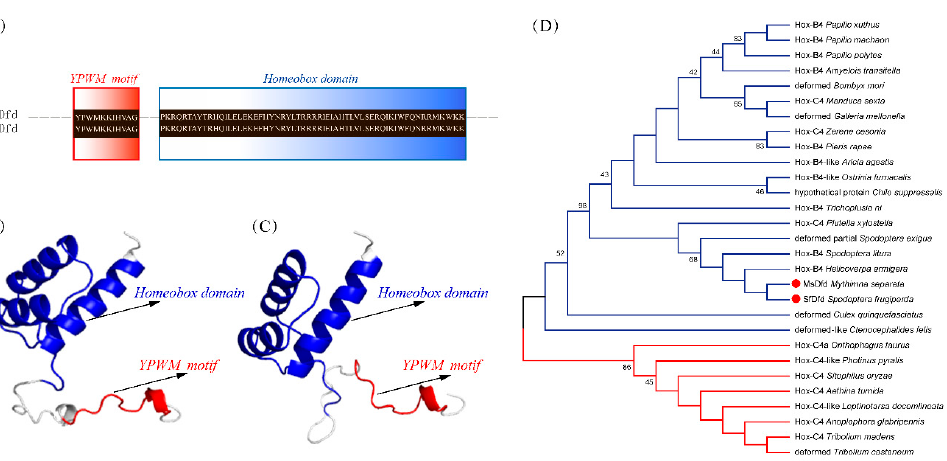
Figure 3. Characterizations of MsDfd and SfDfd. ( A ) YPWM motif and homeobox domain of MsDfd and SfDfd. Predicted protein structures of MsDfd ( B ) and SfDfd ( C ). ( D ) Phylogenetic tree of Dfds. Dfds marked with a red dot are MsDfd and SfDfd. The phylogenetic tree was built using MEGA 7 with the maximum-likelihood method. Red line represents Dfds from Coleopteran insects and blue line represents Dfds of insects from other orders.